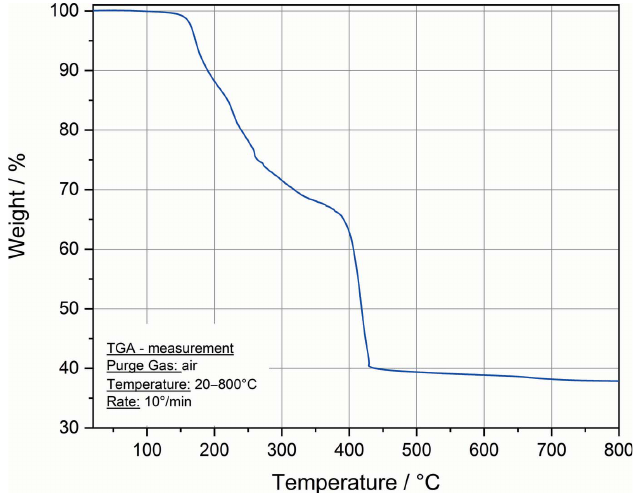
Figure 6 Thermogravimetric analysis for I